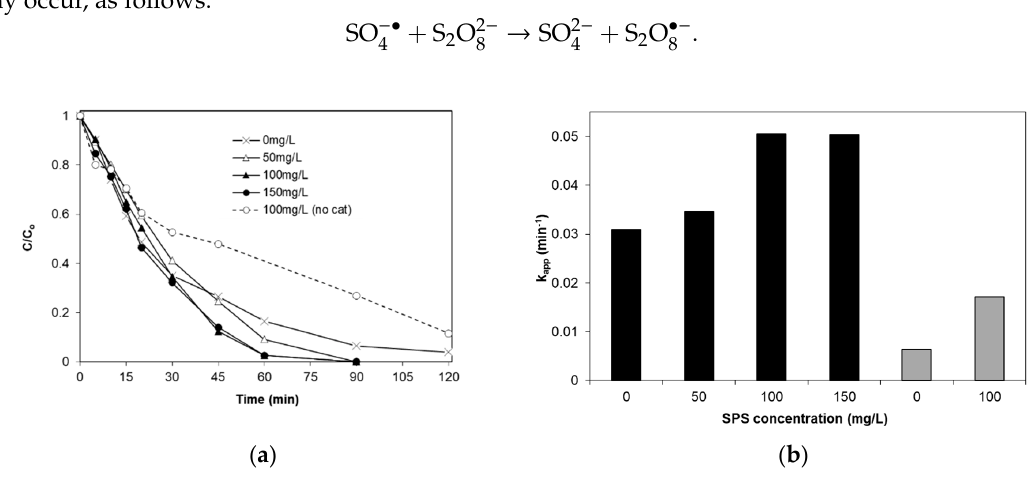
Figure 11. Effect of sodium persulfate on the photolytic and photocatalytic degradation of SMX in UPW ( a ) and apparent kinetic constants ( b ). [SMX] = 234 μ g/L, [0.04%Fe/TiO 2 ] = 1 g/L and natural